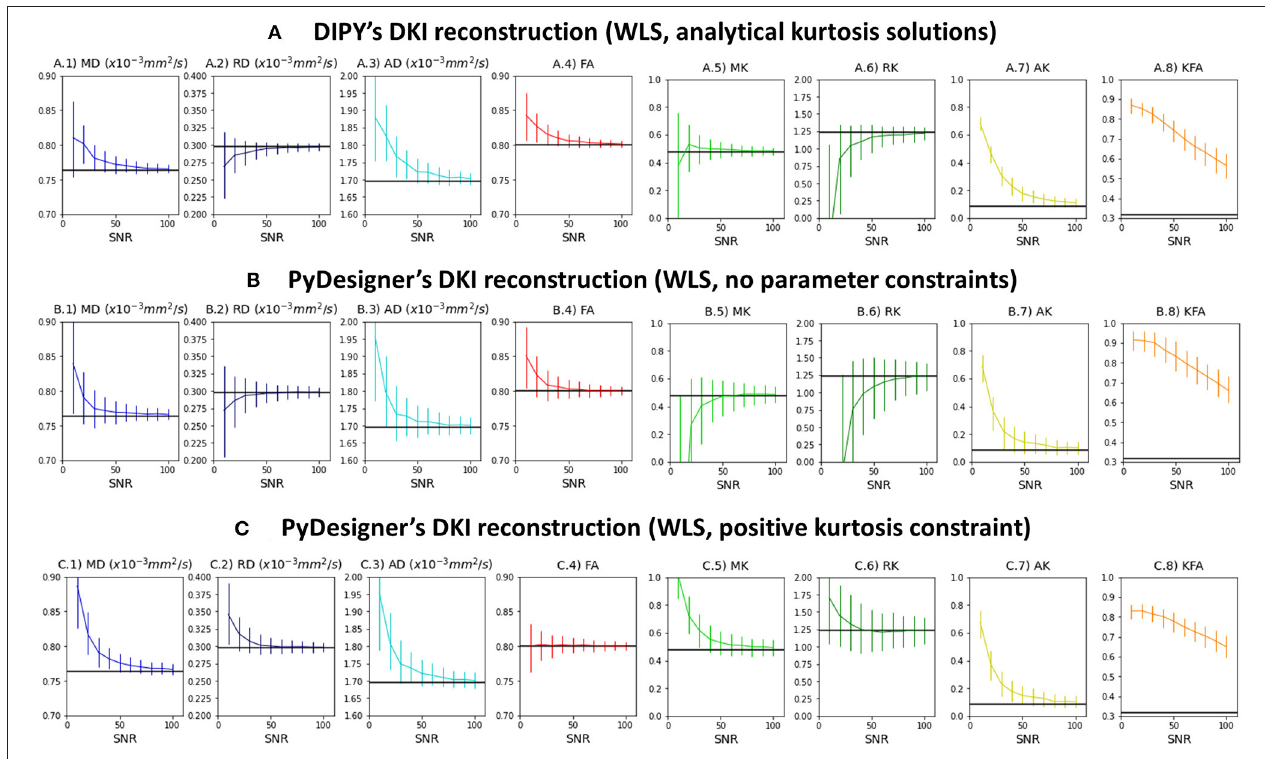
FIGURE 3 | Median and interquartile ranges of the standard kurtosis parameter estimates computed from the synthetic signals of voxel case 2 corrupted with Rician noise—values are plotted as a function of signal SNR. (A) Estimates obtained by DIPY’s DKI NLS fit. (B) Estimates obtained by PyDesigner WLS fit with no parameter constraints. (C) Estimates obtained by PyDesigner WLS fit with directional kurtosis values constraint to positive values. From left to right panels, Figures shows the results for the mean diffusivity (A.1,B.1,C.1), radial diffusivity (A.2,B.2,C.2), axial diffusivity (A.3,B.3,C.3), fractional anisotropy (A.4, B.4, C.4), mean kurtosis (A.5,B.5,C.5), radial kurtosis (A.6,B.6,C.6), axial kurtosis (A.7,B.7,C.7), and kurtosis fractional anisotropy (A.8,B.8,C.8). On each panel, the noise free estimates is marked by the black